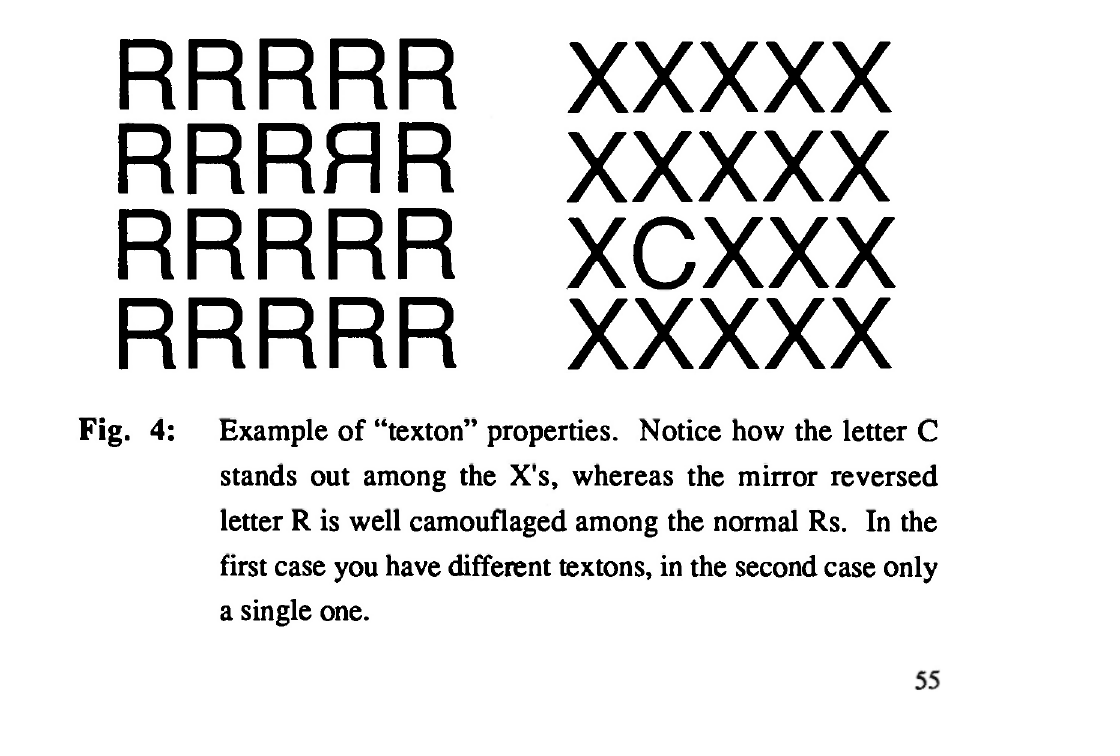
Fig. 3: Example of a good Gestalt. The collection of black dots tends to be seen as a circle, the dots making up the textured circumference. The Gestalt depends on the density of that "texture": with only four dots you see a square rather than a circle.